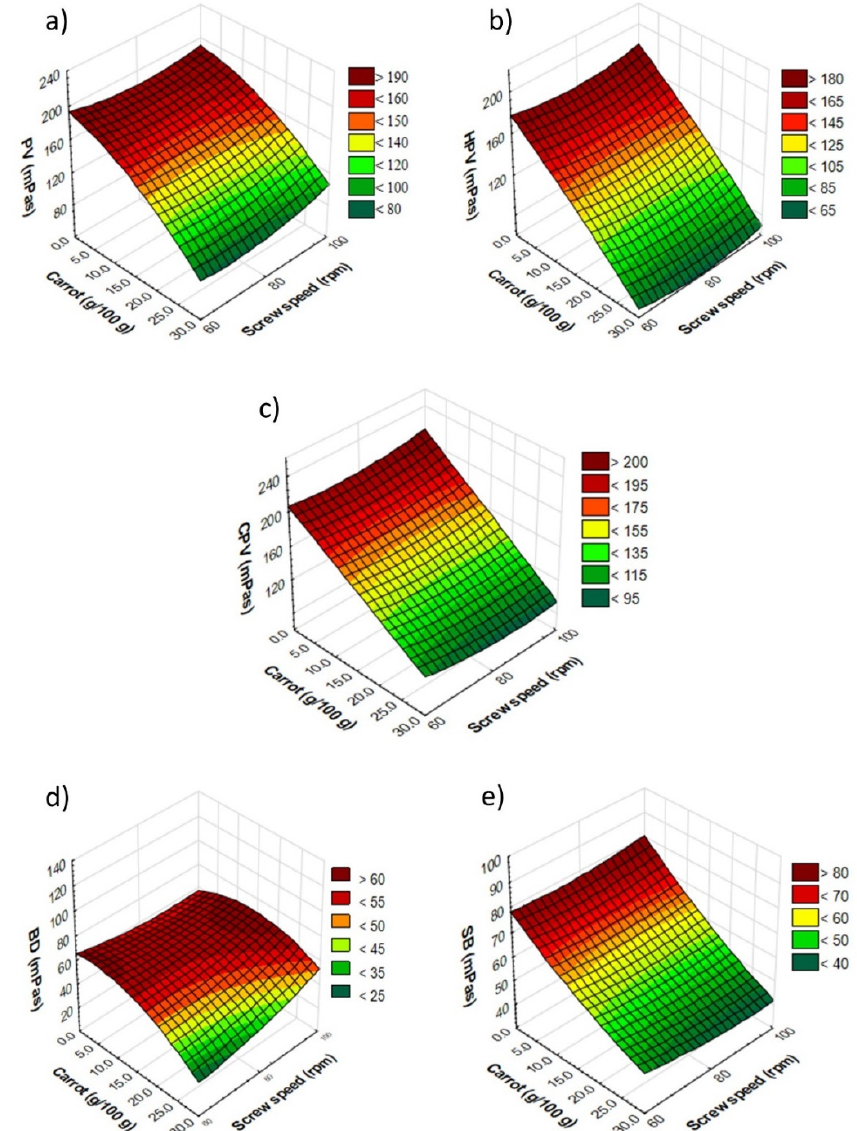
Figure 5. Results of pasting properties of expanded snacks enriched with fresh carrot pulp: ( a ) PV—peak viscosity, ( b ) HPV—hot paste viscosity, ( c ) CPV—cold paste viscosity, ( d ) BD—breakdown, ( e ) SB—setback.